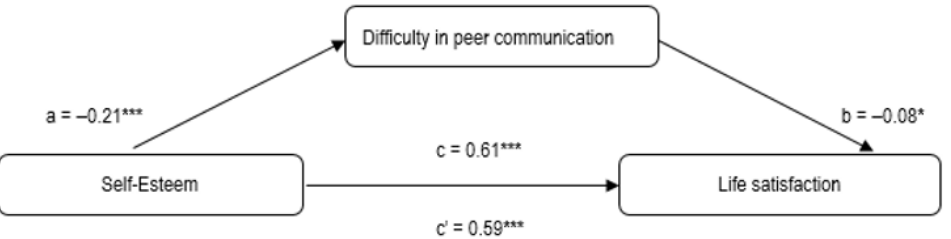
Figure 2. Results of mediation of difficulty in peer communication in the relationship between self- esteem and life satisfaction; *** p < 0.001; * p < 0.05.